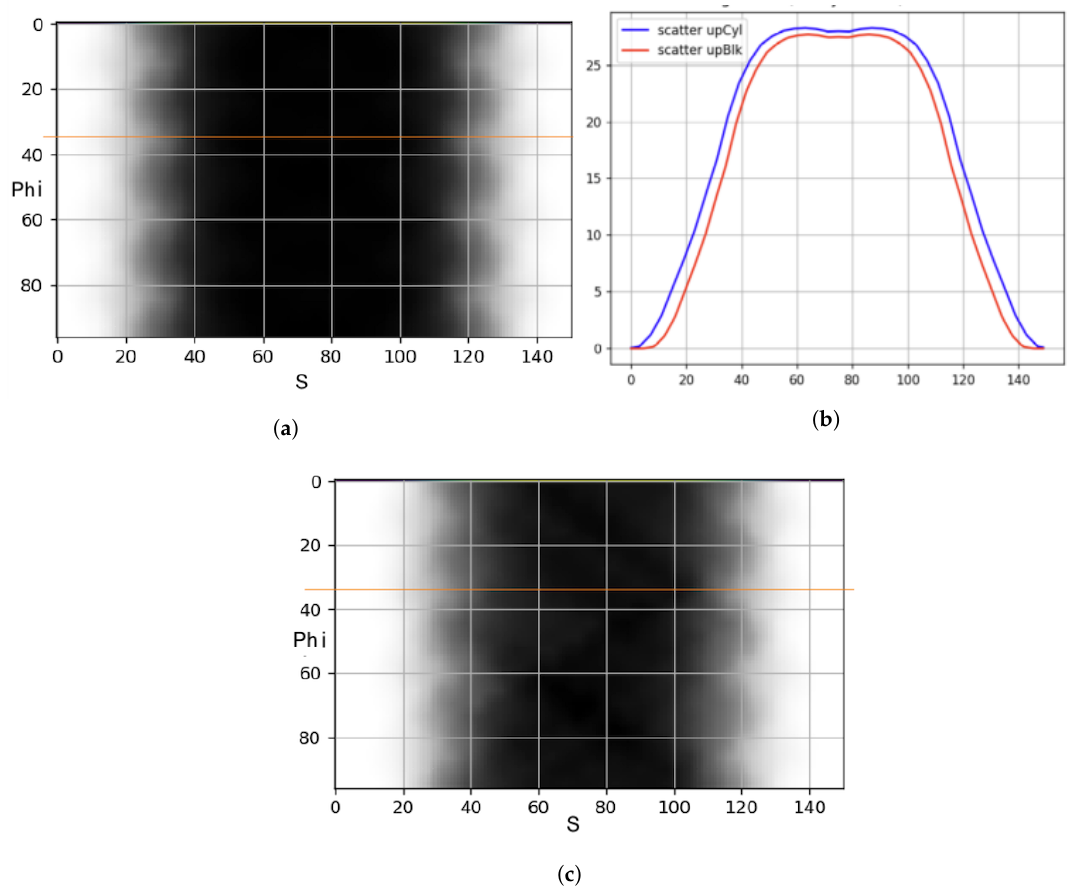
Figure 8. “BlocksOnCylindrical” SSS: using full resolution (top left) and upsampling (bottom left). Line profile of the orange line (shown in sinogram of SSS) of full resolution SSS (blue line) compared to the up-sampled low resolution SSS (red line). ( a ) Full resolution BlocksOnCylindrical SSS. ( b ) Line Profile. ( c ) Upsampled BlocksOnCylindrical